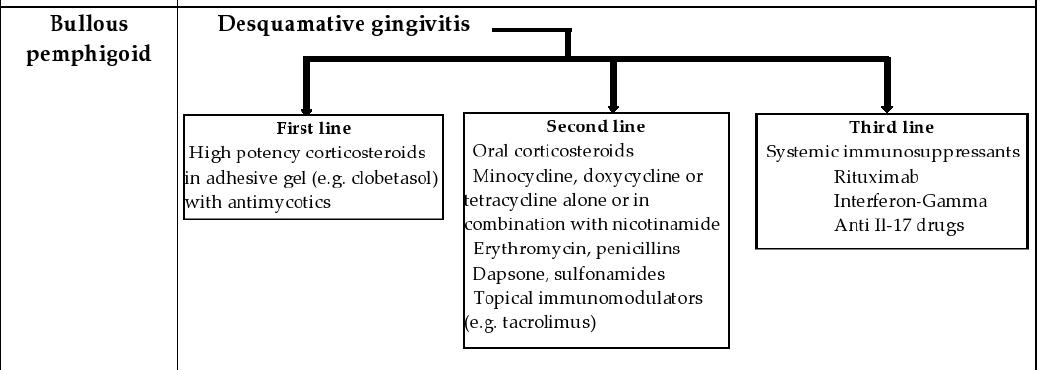
Figure 3. Treatment algorithm for desquamative gingivitis due to bullous